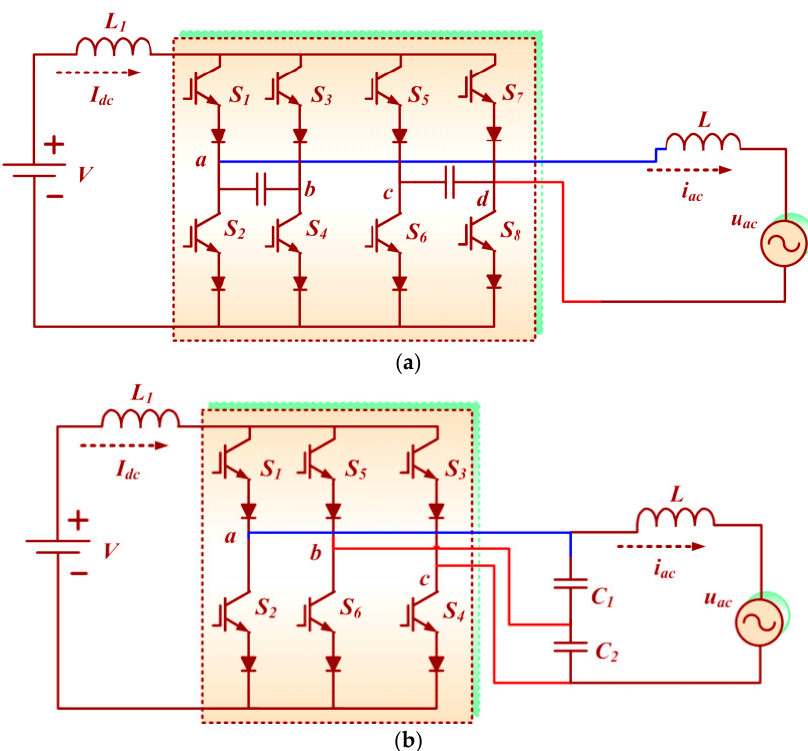
Figure 12. Topology of current source converter with differential-connected structure [39]. ( a ) four leg configuration; ( b ) three leg configuration.